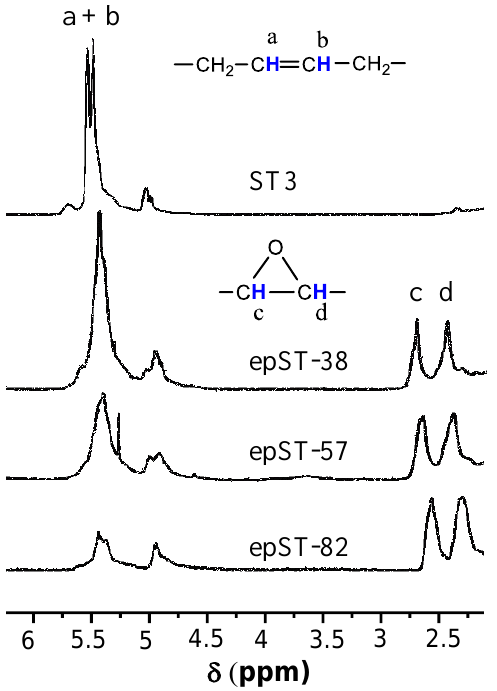
Figure 3. 1 H-NMR spectra of ST and epST-x.